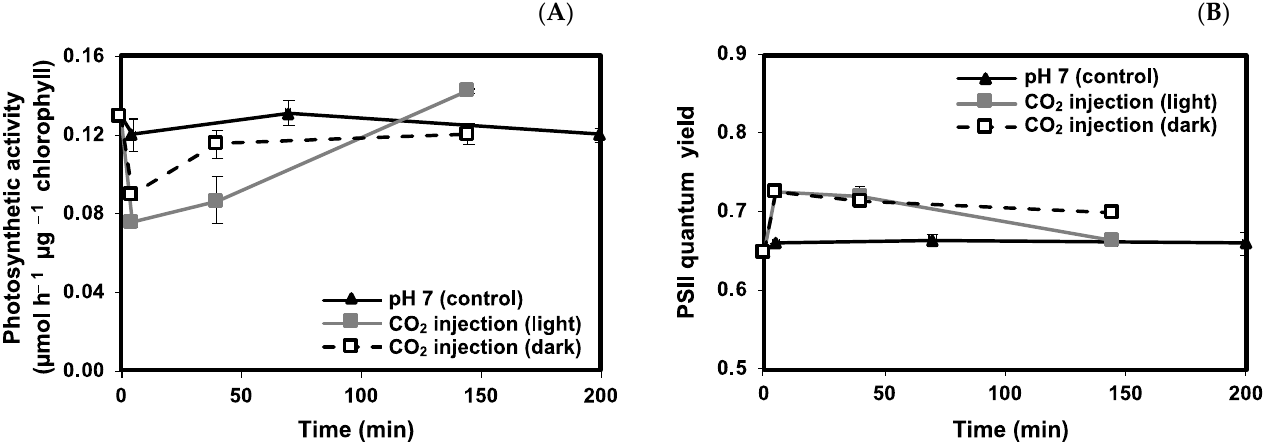
Figure 3. Effect of the pH and DIC concentration changes on microalgae activity. ( A ) Photosynthetic activity when CO 2 injection was applied. ( B ) PSII quantum yield when CO 2 injection was applied. 0.200.250.30 0.15 Figure 4. Photosynthetic activity curves of Chlorella sorokiniana at pH 7.0 and pH 5.0, as a function of the DIC concentration. 0.000.050.10